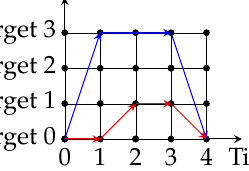
Figure 4. Two example strategies in a reduced version of the patrolling graph of the game. The actual patrolling graph contains nodes with corresponding times up to 1000